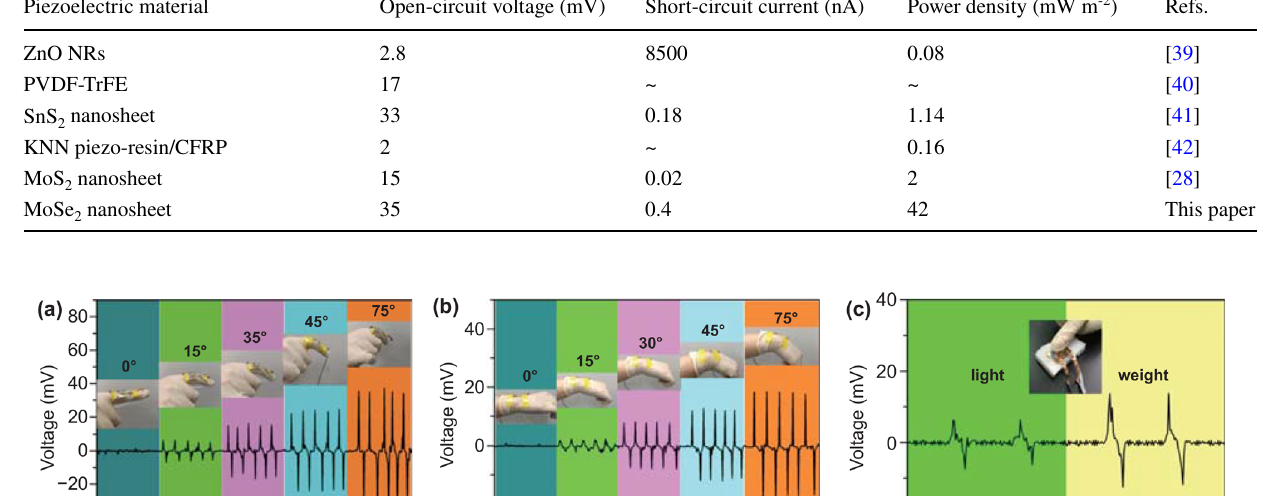
Table 1 Performance of the MoSe 2 PENG in this work compared with the previous work Piezoelectric material Open-circuit voltage (mV)